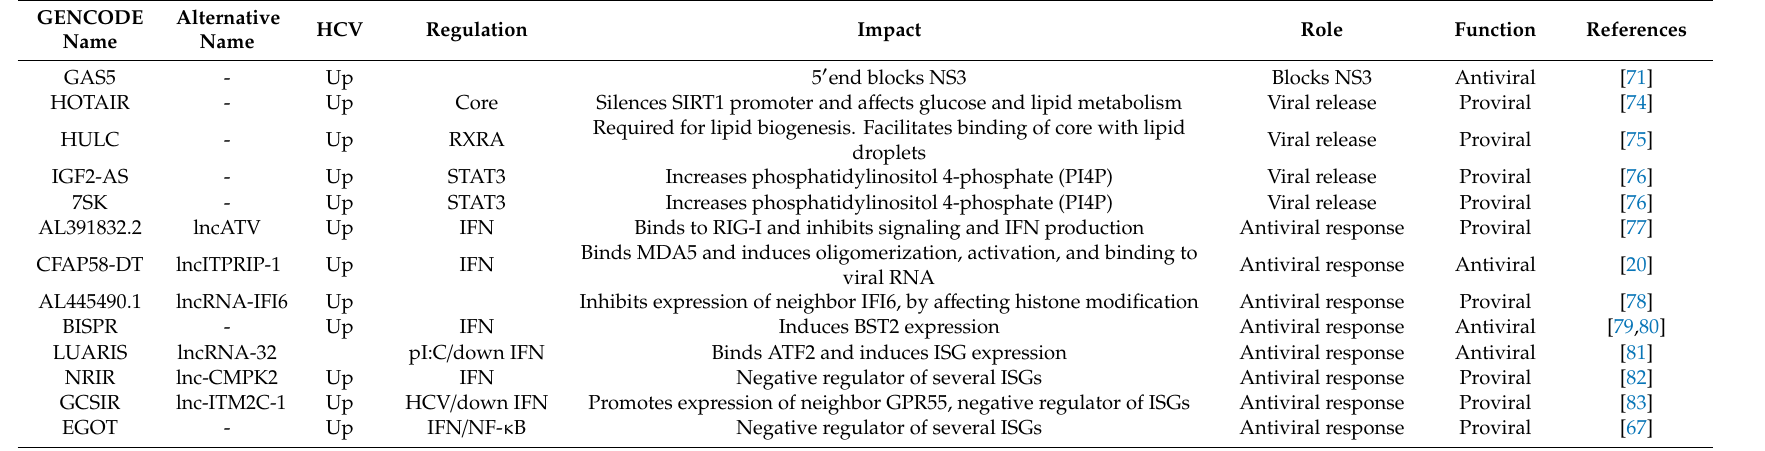
Table 1. LncRNAs deregulated in HCV viral cycle and antiviral